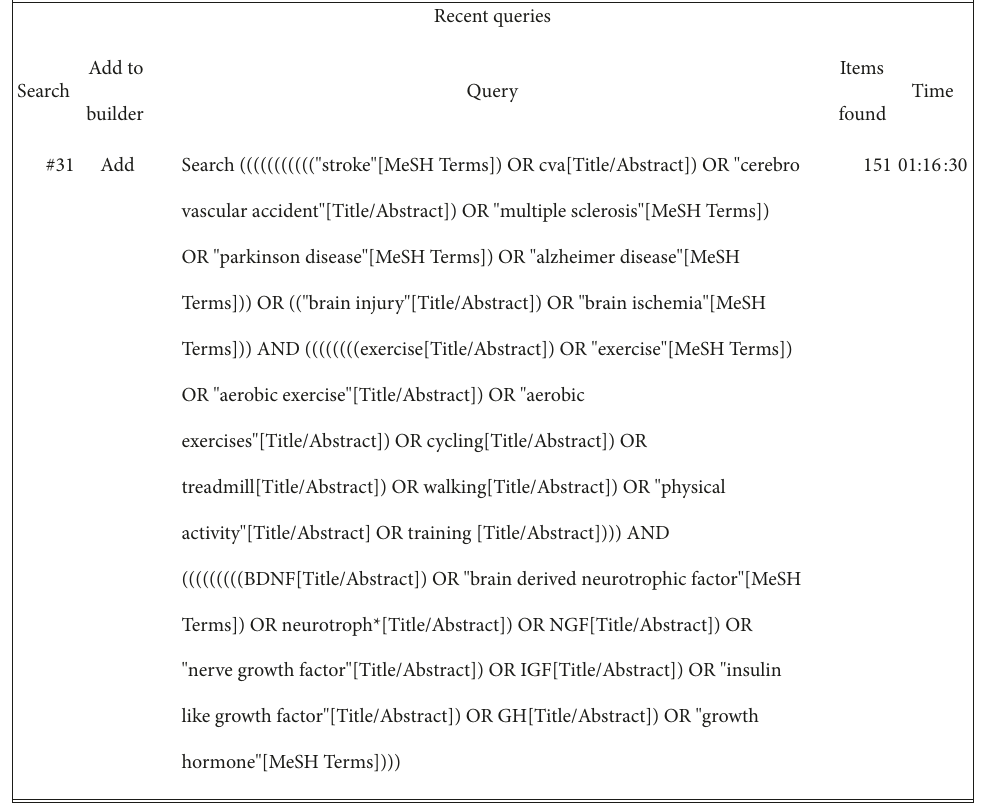
Figure 1: Database search history —